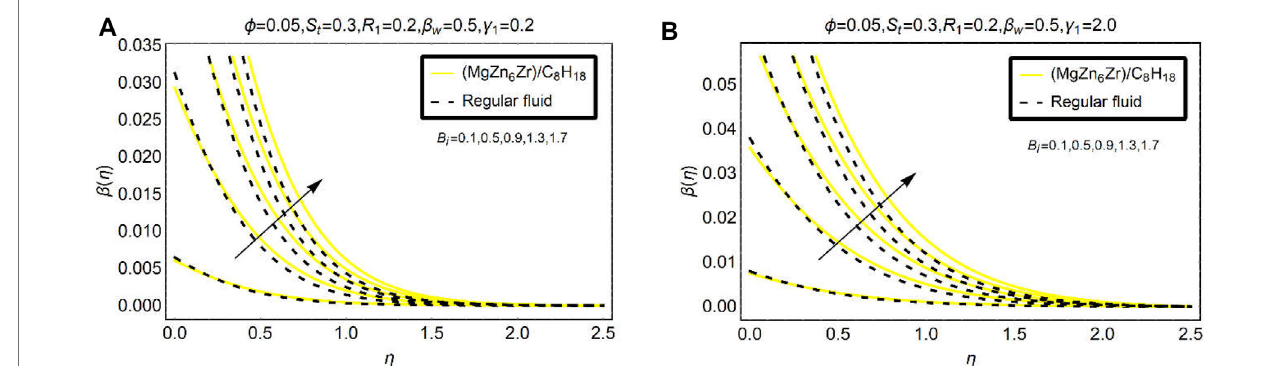
FIGURE 9 | Temperature via B i (A) γ 1 (cid:2) 0 . 2 and (B) γ 1 (cid:2) 2 . 0.